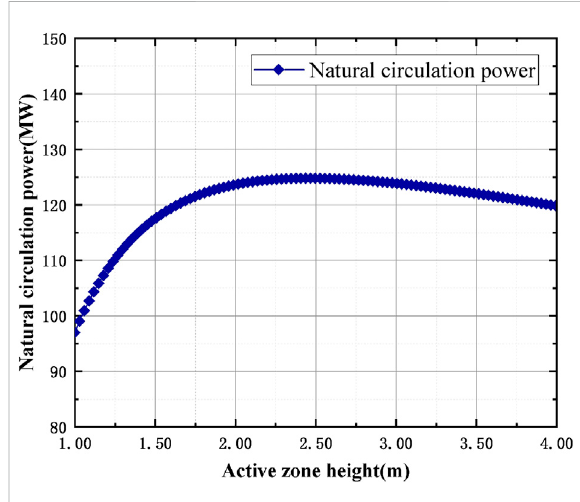
FIGURE 10 Natural circulation power of SPALLER at different heights.